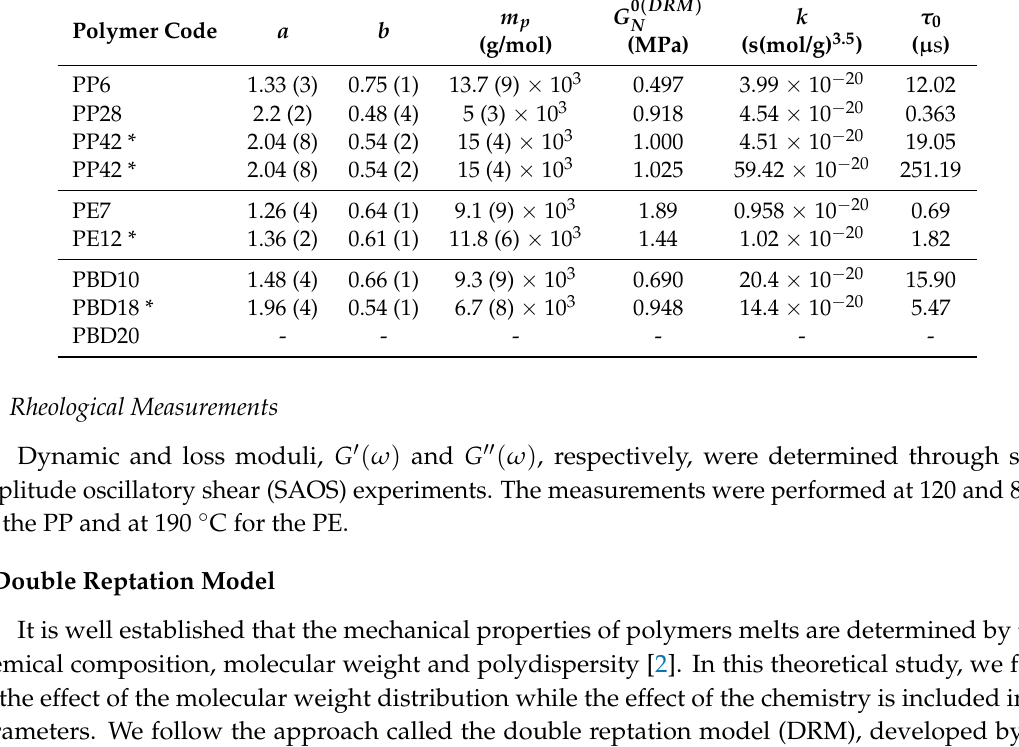
Table 2. GEX parameters to describe the W ( M ) of PBD, PP and PE melts analyzed here. We also show ( DRM ) our estimation for the plateau modulus parameter G 0 , the parameter k , and the characteristic N time τ 0 for the double reptation model described in Ref. [25]. The * indicates our reference system for which we estimated the value of G 0 used in the DSM approach, as explained in the main text. N Polymer